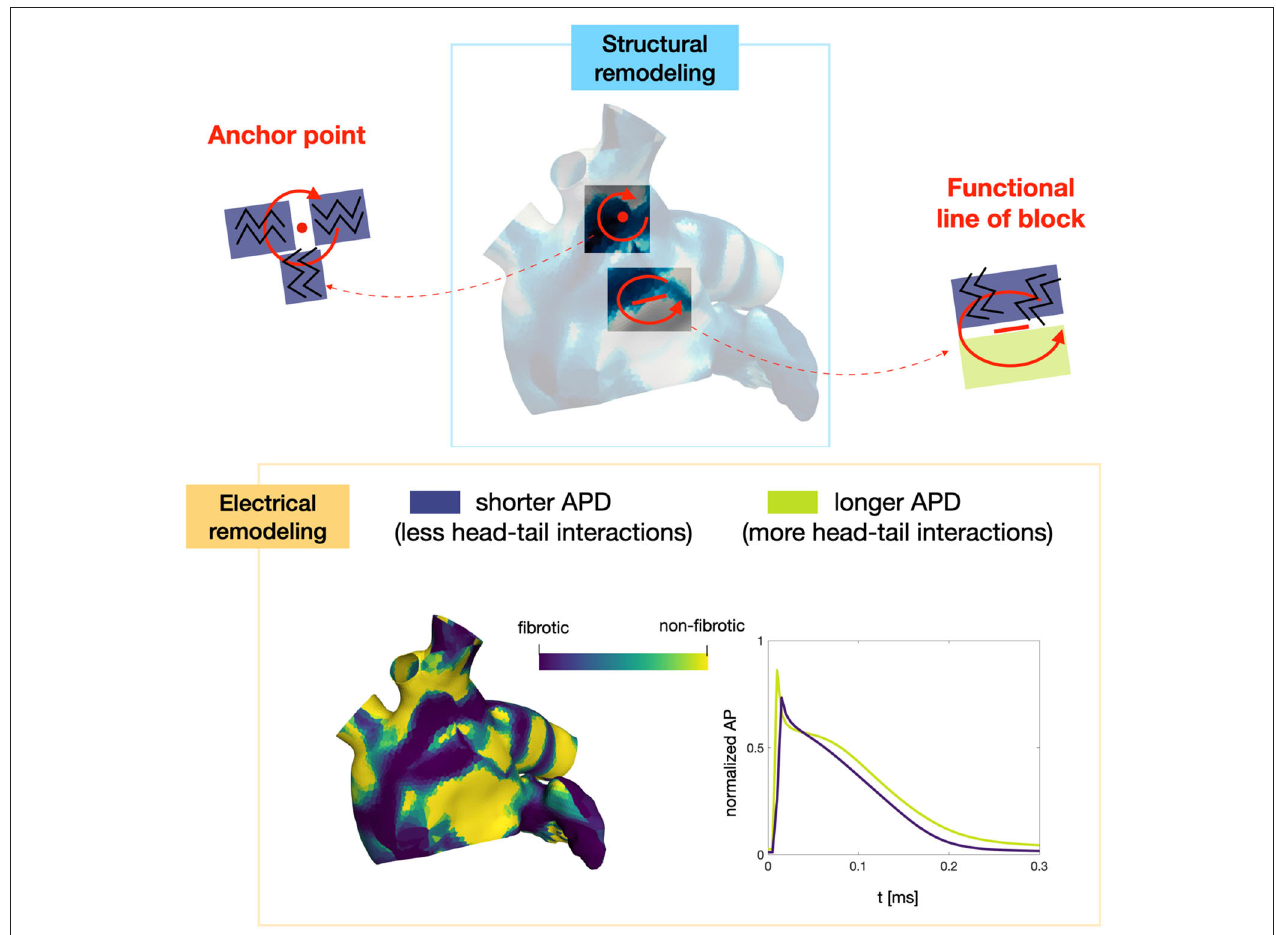
FIGURE 8 | Role of the electrical and structural remodeling in the formation of localized reentries. The formation of functional lines of block occurs in areas of heterogeneous tissue, where the wavefront is likely to meet its tail due to conduction and APD heterogeneity. In areas of severe slow conduction, the rotor stabilize thanks to the low wavefront’s speed and the short